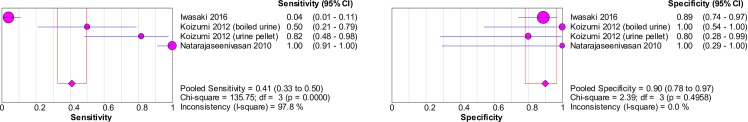
Forest plots of sensitivity and specificity of studies using flaB as the target gene for the detection of Leptospira.